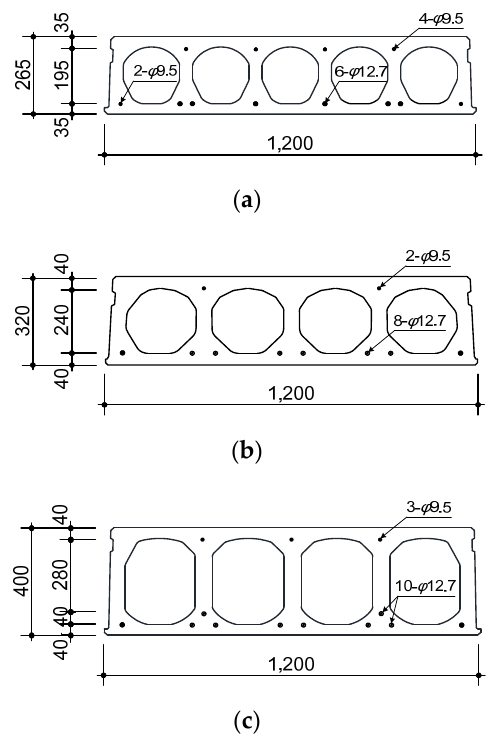
Figure 3. Details of S series (unit: mm): ( a ) S265; ( b ) S320; ( c ) S400.